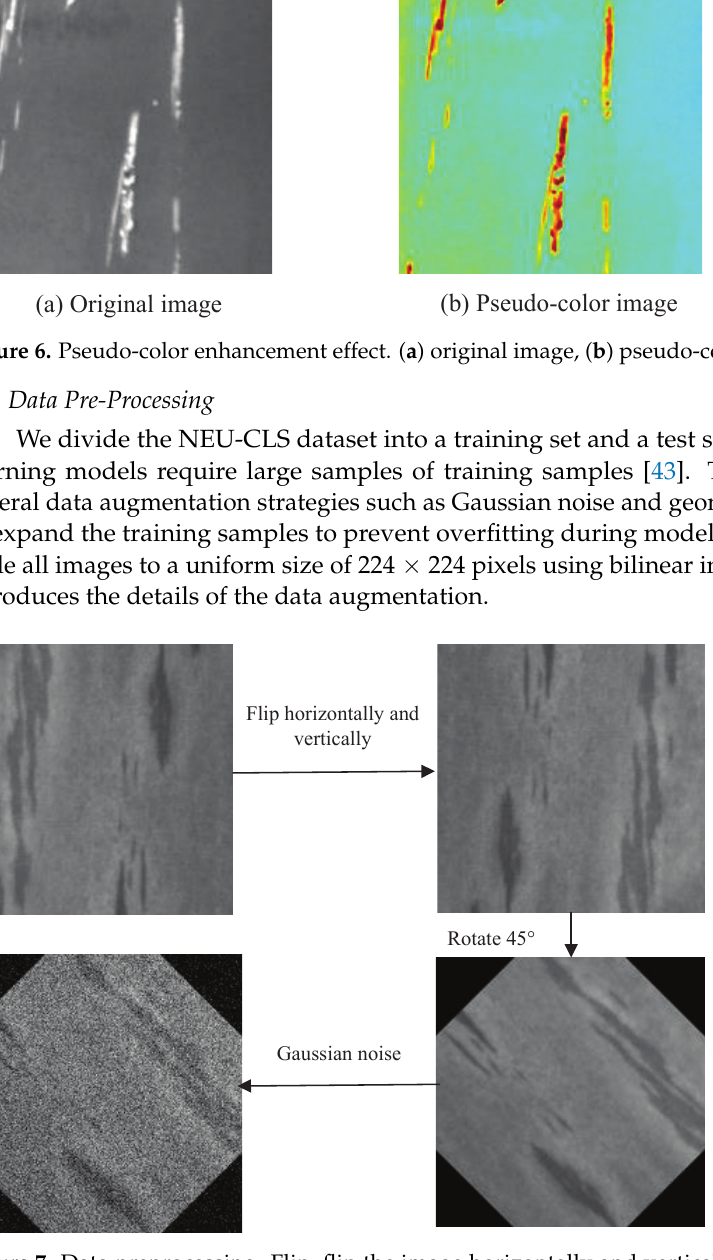
Figure 7. Data preprocessing. Flip, flip the image horizontally and vertically. Rotation, rotate the picture 45 degrees separately. Random crop, randomly crop different parts of the picture. Add noise, add Gaussian noise to the